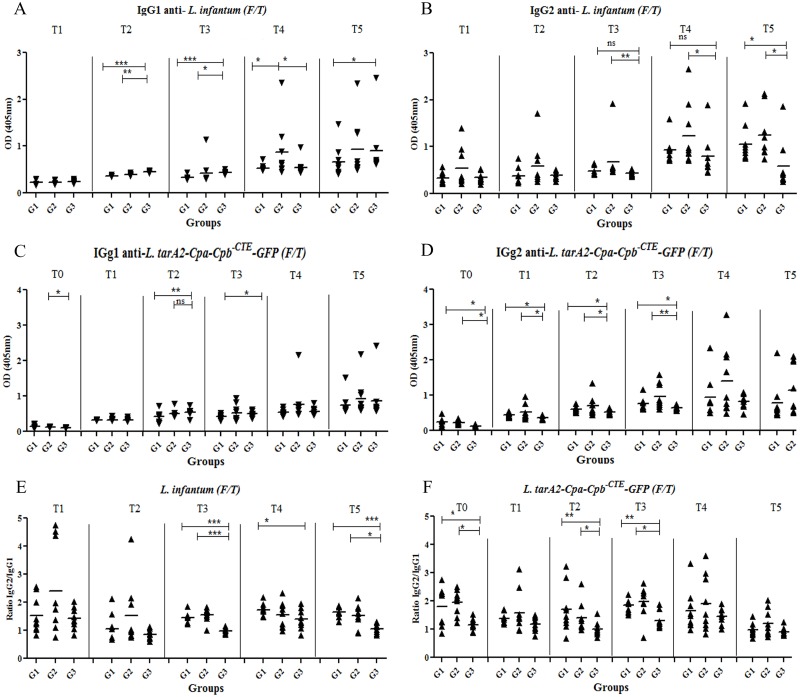
Analysis of specific humoral response elicited in vaccinated and controls groups.Serum from all dogs was obtained at different time points throughout the experiment. T0: before challenge at day 41; T1: 2 months after challenge at day 60; T2: 6 months after challenge at day 180; T3: 11 months after challenge at day 330; T4: 14 months after challenge at day 420; T5: 17 months after challenge at day 510. Anti-L. infantum (F/T) IgG1 (A), anti-L. infantum IgG2 (B) and anti-L. tarentolae A2-CPA-CPB-CTE-EGFP (F/T) IgG1 (C), anti-L. tarentolae A2-CPA-CPB-CTE-EGFP (F/T) IgG2 (D), IgG2/IgG1 ratio against L. infantum (F/T) (E) and IgG2/IgG1 ratio L. tarentolae A2-CPA-CPB-CTE-EGFP (F/T)(F) production were determined by ELISA. The asterisk indicates the significant difference between values at the indicated time points as determined by Student’s test (p< 0.05 denoted as *, p<0.01 denoted as **, p<0.001 denoted as *** and n.s. denoted as non significant).